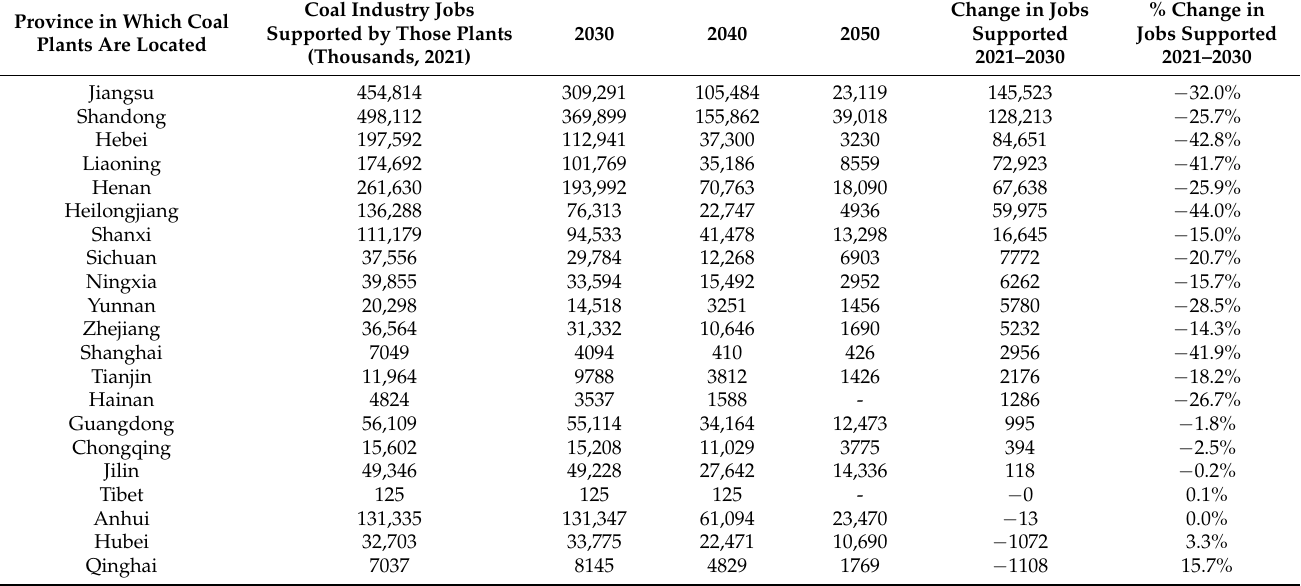
Table A3. Trends in coal industry employment supported by each province, 2021–2060 and change